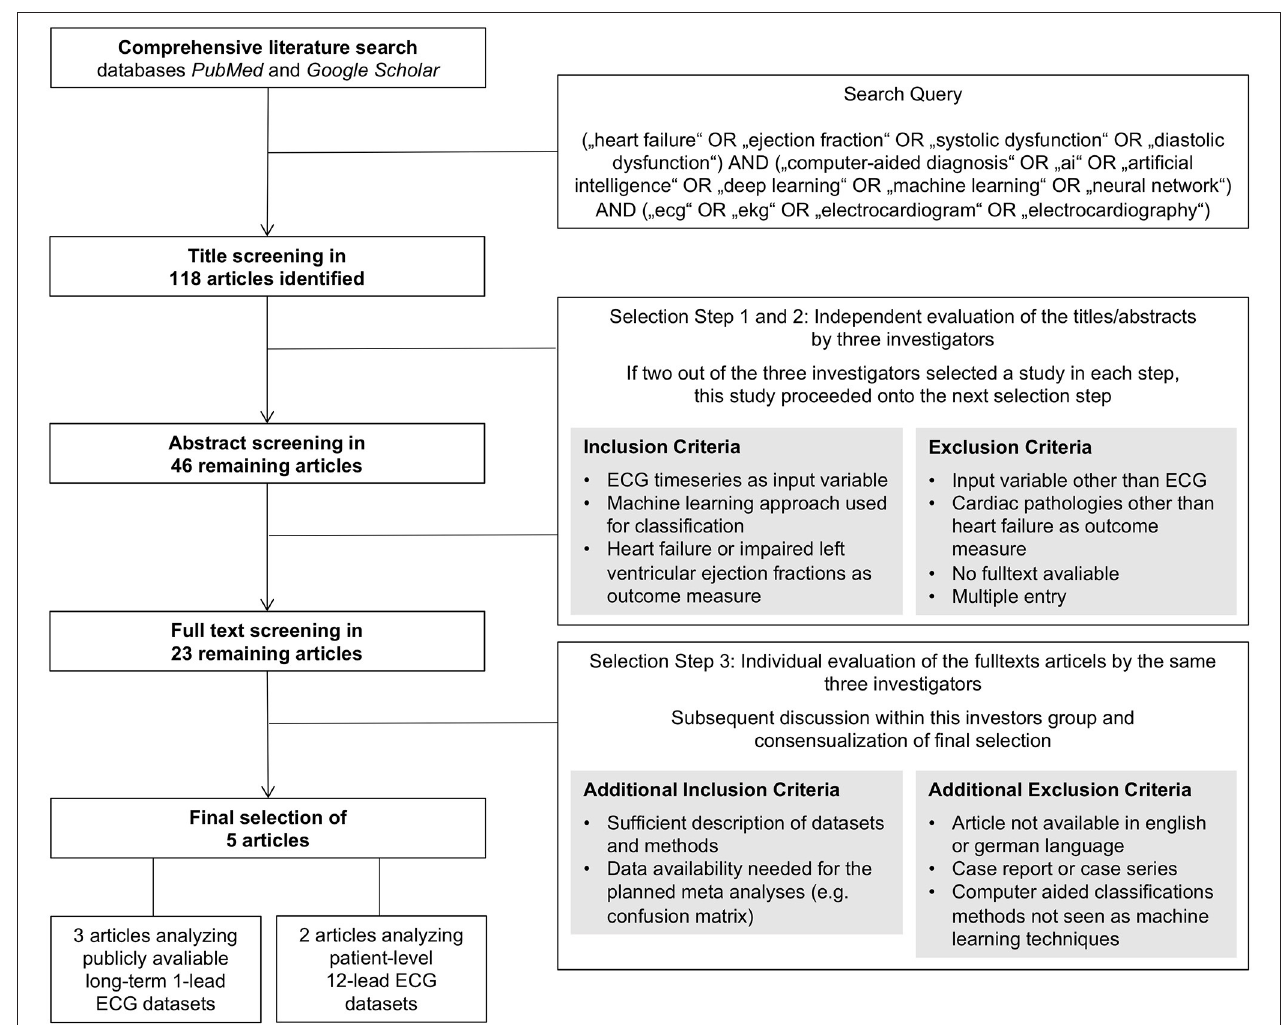
FIGURE 1 | Flowchart summarizing the literature screening and study selection process.